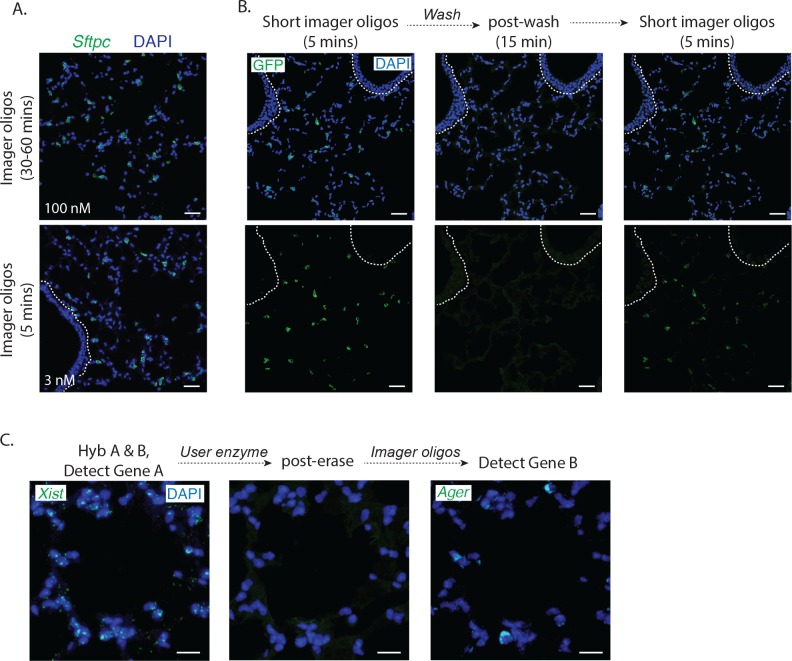
Rapid label-image-erase strategies without tissue degradation.(A) Imaging with and without washout of fluorophore-labeled 'imager' oligonucleotides gives identical signal-to-noise ratios. Mouse lung tissue sections were interrogated with a single PLISH probe pair targeting Sftpc (green). In the top panel, the tissue section was hybridized with 100 nM imager oligonucleotides then washed (to remove excess imager oligonucleotides) prior to imaging, which took 30–60 min. In the bottom panel, the tissue section was hybridized with 3 nM imager oligonucleotides then imaged without a wash step, taking only 5 min. Bronchioles indicated by dashed lines. Sftpc, surfactant protein C; Scale bar, 40 μm. (B) Signal erasure by dissociation of short imager oligonucleotides. PLISH puncta for Sftpc (green) were visualized with short (11 base pair) imager oligonucleotides (first column). The signal was then erased by washing at 37°C for 15 min and re-imaged (middle column), showing no residual fluorescence. The sample was then re-stained with short imager oligonucleotides and re-imaged (third column), showing re-emergence of the fluorescent signal. The cycle time was 25 min. Bronchioles indicated by dashed lines. Sftpc, surfactant protein C; Scale bar, 40 μm. (C) Signal erasure by enzymatic digestion of imager oligonucleotides. PLISH puncta for Xist (green) were visualized in mouse lung with uracil-containing imager oligonucleotides (left panel). The tissue section was then incubated with the New England Biolabs USER enzyme cocktail at 37°C for 20 min to digest the imager oligonucleotides and re-imaged (middle panel), then re-stained with a new set of imager oligonucleotides for Ager (green, right panel). The cycle time was 25 min. Ager, advanced glycosylation end product-specific receptor; Xist, inactive X specific transcripts; Scale bar, 20 μm.